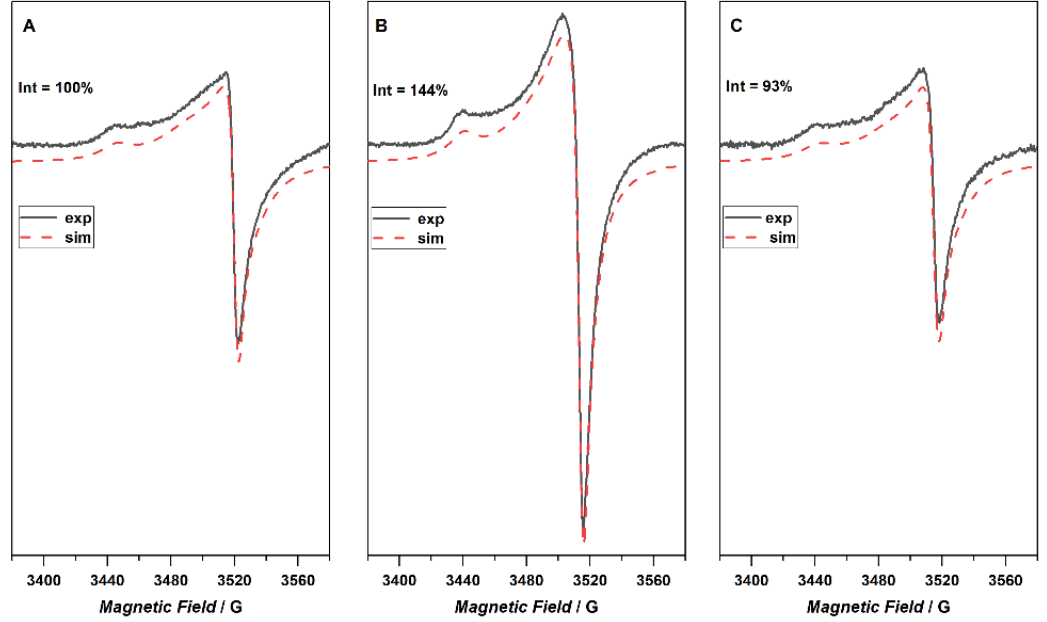
Figure 8. EPR spectra of plasma-treated graphite. ( A ) reference graphite; ( B ) measured as soon as possible after plasma treatment; ( C ) plasma and water treated sample.